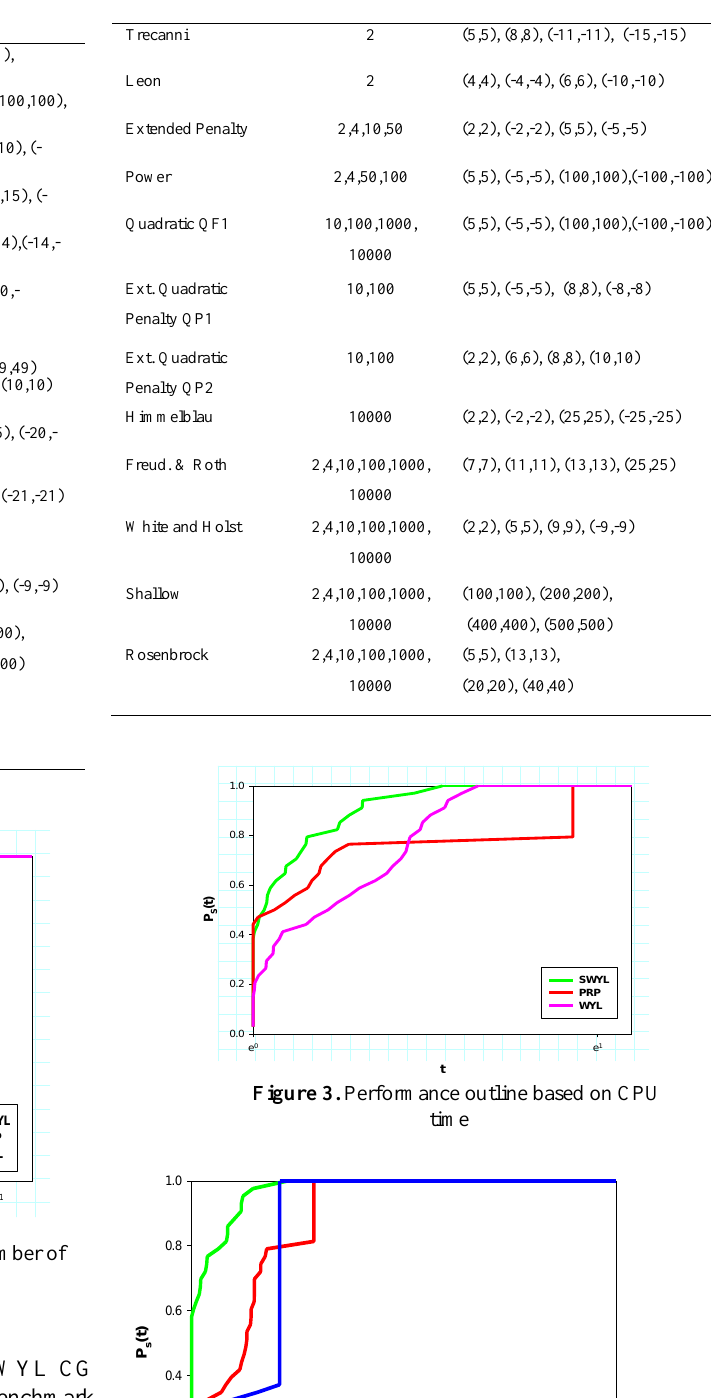
Table 6. Standard Test Problems functions for Figure 4 and Figure 5 Functions